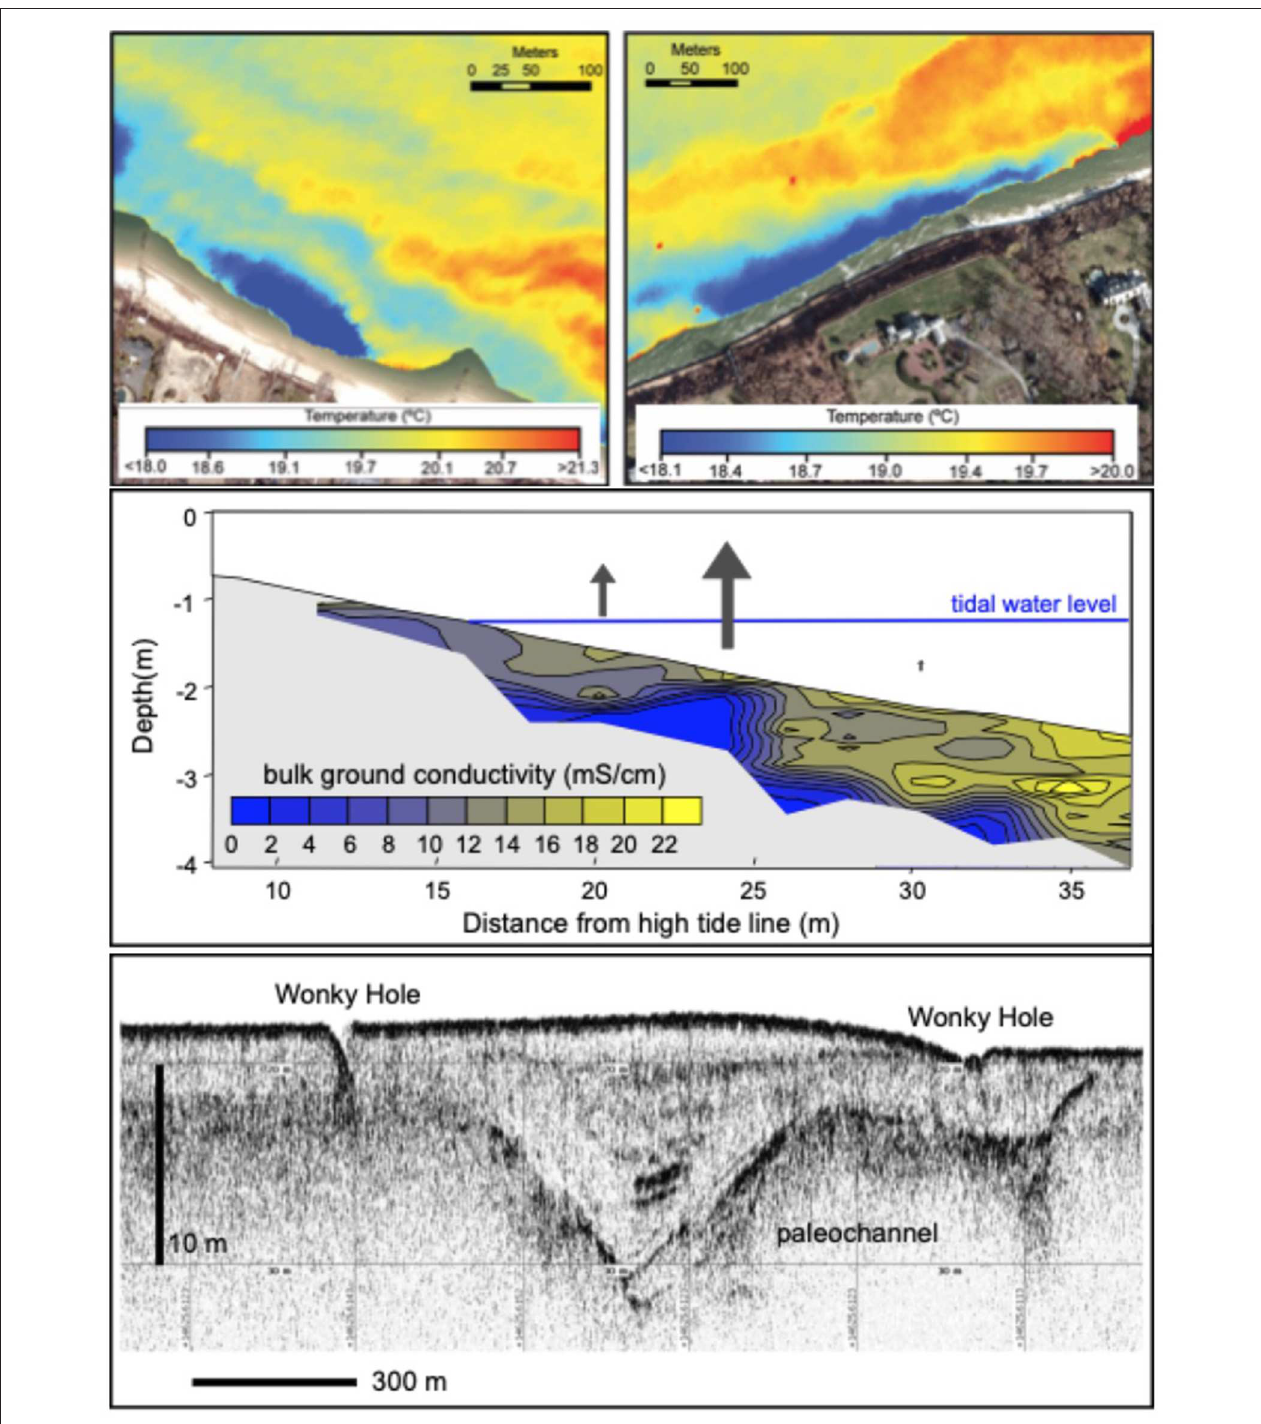
FIGURE 4 | (Top) Airborne Infrared maps from beaches on Long Island (USA) elucidating cold SGD plumes (adapted from Tamborski et al., 2015); (Center) bulk ground conductivity transect indicating preferential freshwater SGD flow path. Arrow length indicates SGD flow rates measured with seepage meters at the respective locations (adapted from Stieglitz et al., 2008a); (Bottom) Sub-bottom (seismic) profile of a riverine paleochannel and associated Wonky Holes (Great Barrier Reef, Australia) (Stieglitz, unpublished data).